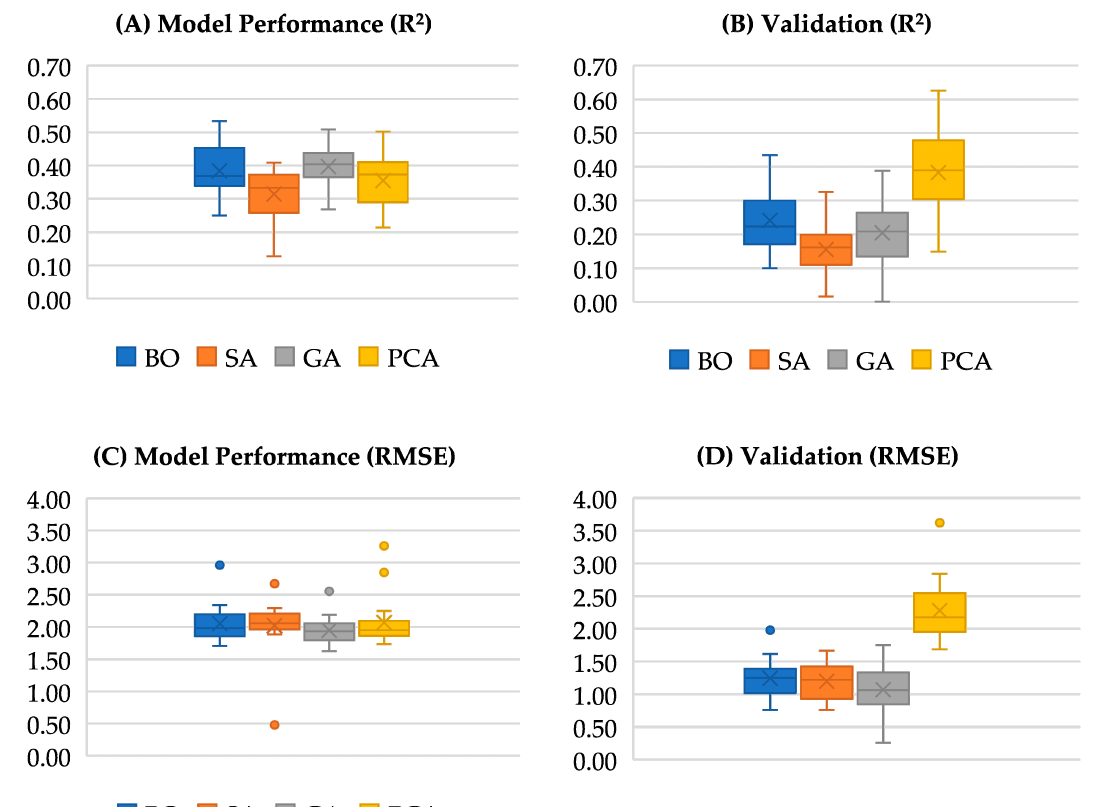
Figure 12. Performance of variables selected from different variable selection algorithms when used for modeling forest height.